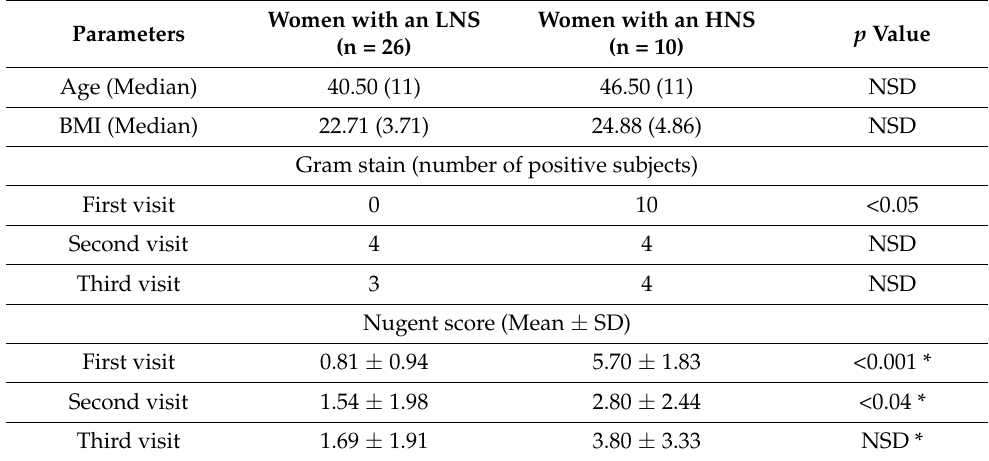
Table 1. Clinical characteristics of asymptomatic women after Nugent scoring. Women with an LNS Women with an Parameters (n = 26)